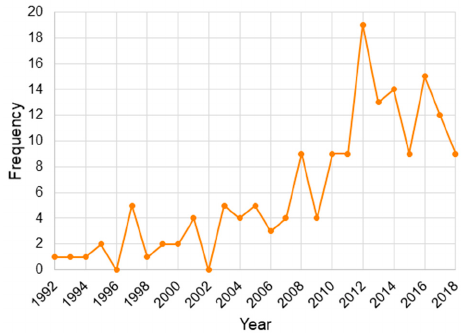
Figure 6. Yearly distribution of the selected studies, published on associations of the outdoor environment with low birth weight (LBW), birth weight, and small for gestational age (SGA), within Canada and the USA.